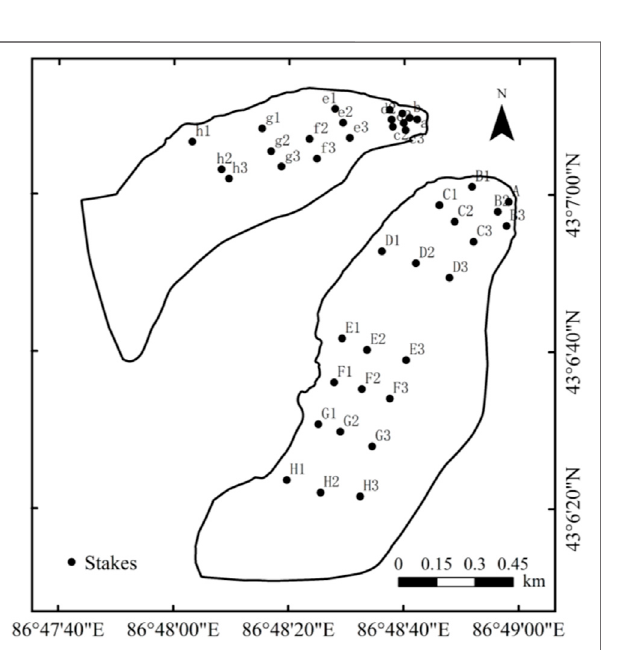
FIGURE 3 | The locations of stakes on the glacier surface.